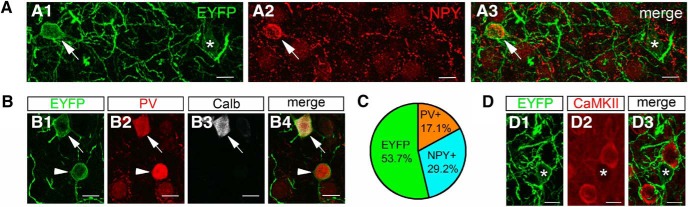
GABAergic cells labeled with intersectional viral strategy represent different populations of INs. A, Example of EYFP-expressing cells (panel A1) that either are (panel A2, arrow) or are not (panel A3, asterisk) also immunopositive for NPY (scale bar = 10 µm). B, Example of two EYFP-expressing cells (panel B1, arrow and arrowhead) that both contain PV (panel B2), but only one of which is also immunopositive for Calb (panel B3, arrow; scale bar = 10 µm). C, Pie chart showing the ratio of EYFP-expressing neurons that contain PV or NPY. Note a large proportion of cells does not express either PV or NPY. D, Example of EYFP-expressing cell (panel D1, asterisk) and non-overlapping cells immunopositive for CaMKII (panels D2, D3; scale bar = 10 µm).